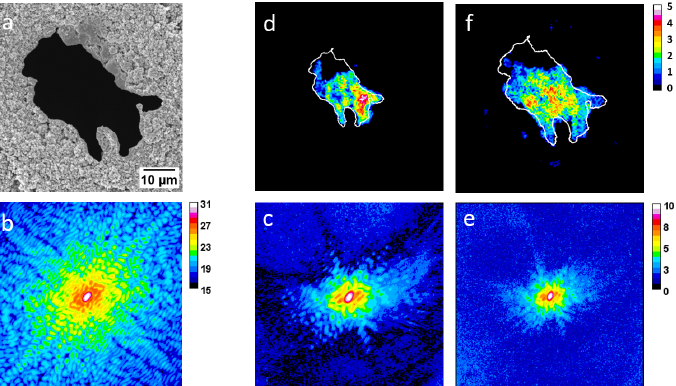
Figure 7. ( a ) The object under ultrafast CDI study. ( b ) The ideal CDI result corresponding to the object shown in ( a ). ( c ) CDI result for the object shown in ( a ) using the central wavelength of 47.6 nm. ( d ) Reconstruction of the object shown in ( a ) using the CDI result of ( c ). ( f ) CDI result for the object shown in ( a ) using the central wavelength of 32.2 nm. ( f ) Reconstruction of the object shown in ( a ) using the CDI result of ( e ). The white contour shown in ( d , f ) corresponds to the shape of the object shown in ( a ) and was placed to guide the eye. The image size of ( b – f ) is 512 × 512